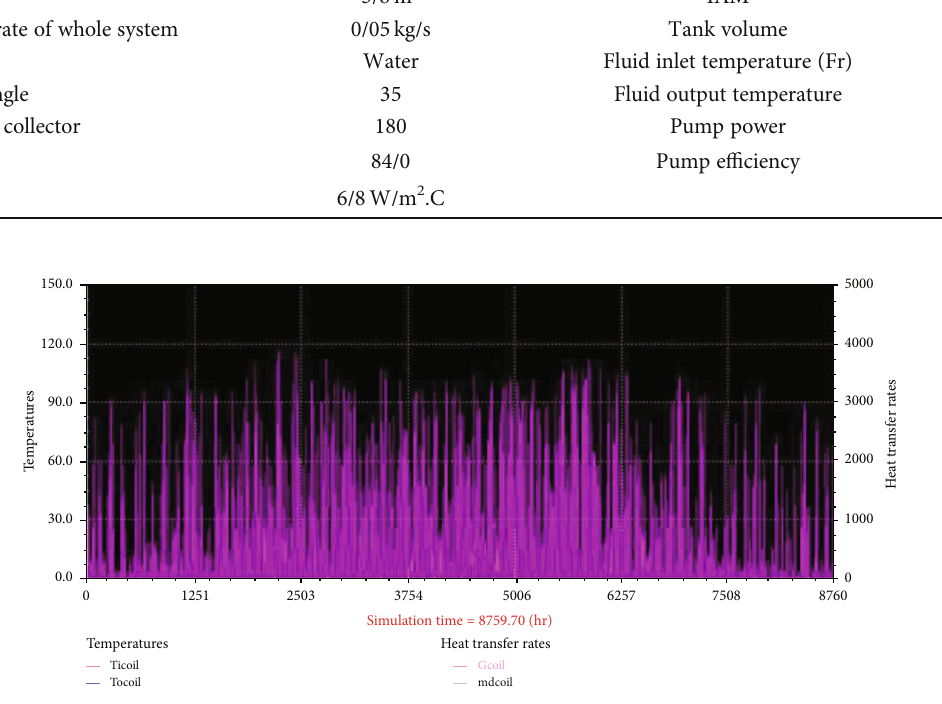
Figure 9: Thermal energy generated by the solar water heater system.